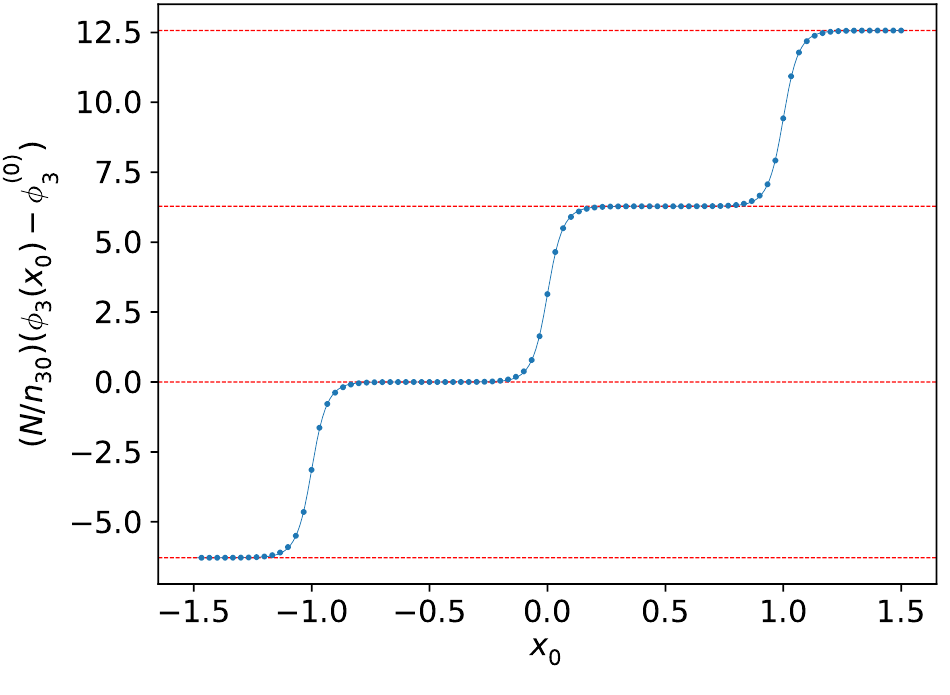
Figure 11. We display, for the SU(3) instanton configuration with l 0 = l 3 , the phase of the Polyakov loop P multiplied by N/n compared to the ansatz of eq. (4.6) with ξ = 0 . 999999999535 3 30